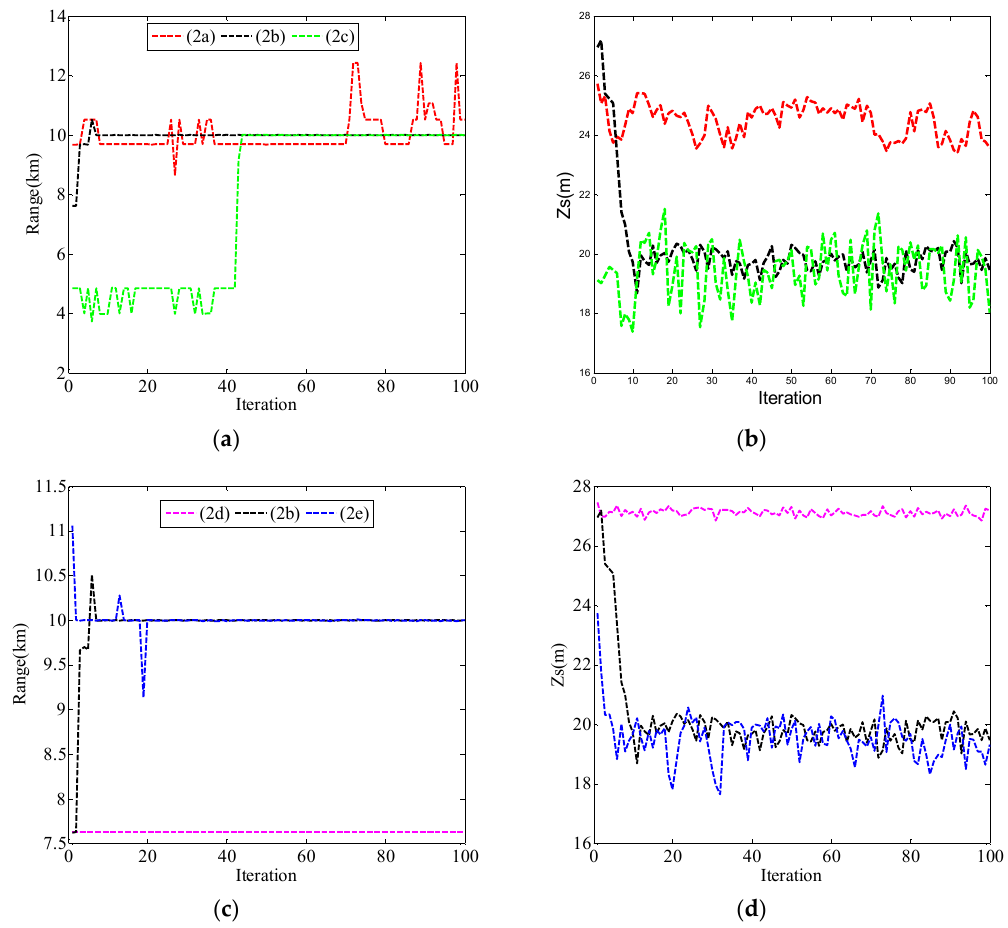
Figure 3. Localization results for particle filtering (PF) with different values of Q 1/2 the initial value of x was [9500, 25] T . ( a ) Range estimation results in cases (1a), (1b), and (1c); ( b ) source depth estimation results in cases (1a), (1b), and (1c); ( c ) range estimation results in cases (1d), (1b), and (1e); ( d ) source depth estimation results in cases (1d), (1b), and (1e).